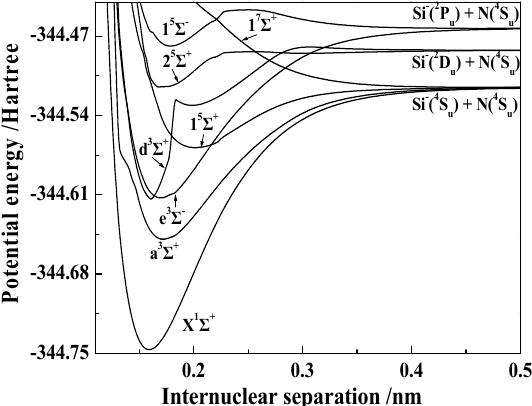
Figure 1. PECs of the 8 Λ -S states with the Σ symmetry of the SiN − anion.